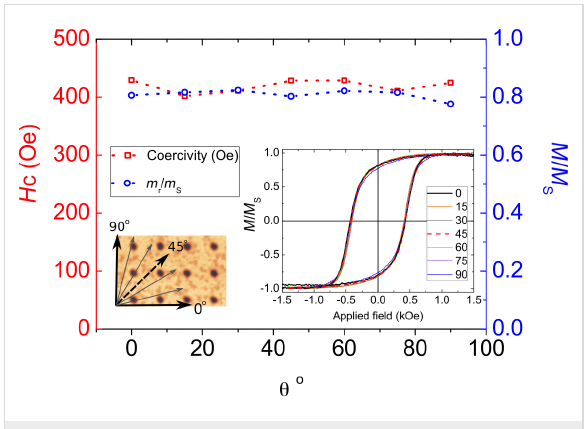
Figure 6: Coercivity (red squares) and normalized remanence (blue dots) as a function of the angle θ at which the external magnetic field is applied for a square array with lattice parameter 360